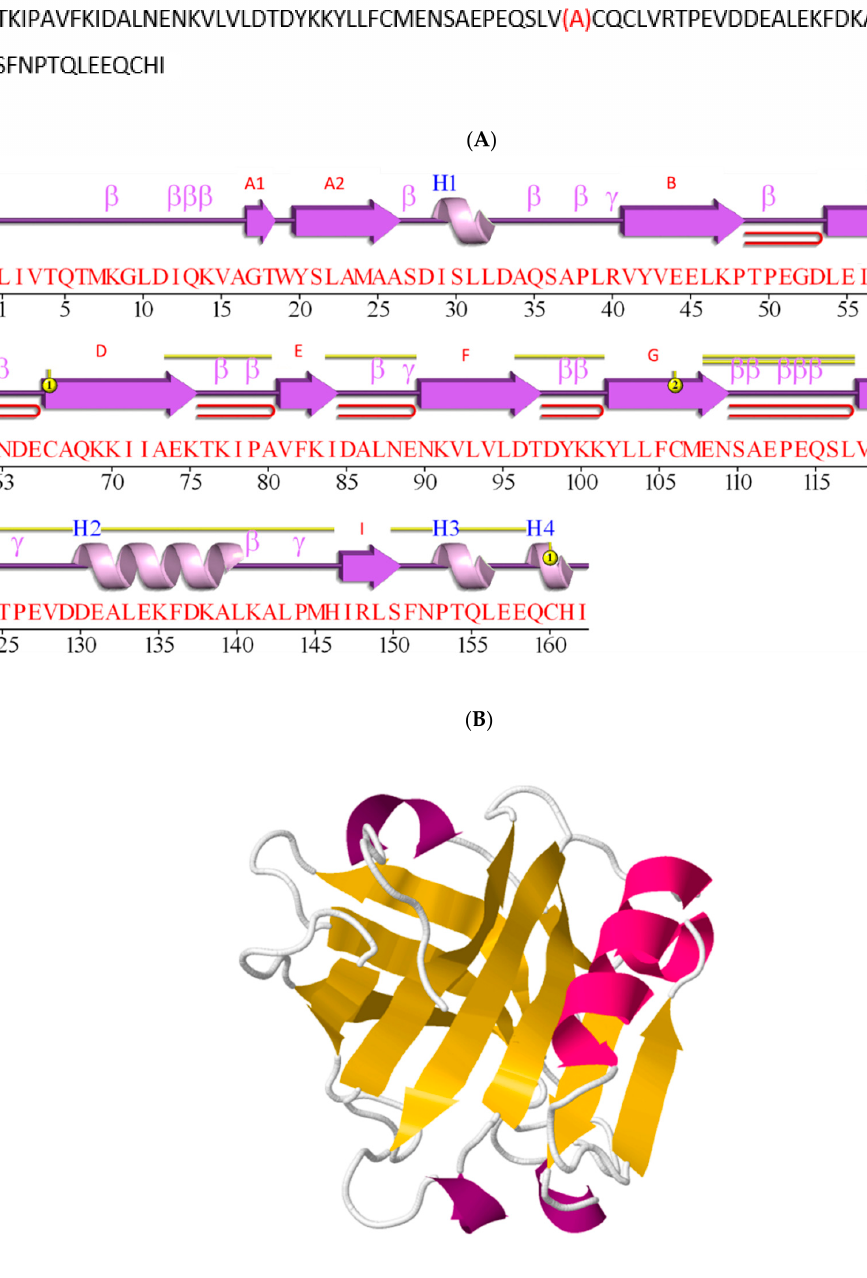
Figure 1. Structural features of bovine β -lactoglobulin. ( A ). Primary sequence of β -lactoglobulin variant A (B). ( B ). Diagram of secondary structural features of β -lactoglobulin. H1–H4, helical segments; A1–I, beta sheets; β , beta turn; γ , gamma turn; 1 (cid:79) = 2 (cid:79) ; disulphide bonds. Figure generated using PDBsum, PDB ID 1BSO [30], ( C ). Crystal structure of monomer of bovine β -lactoglobulin monomer, PDB ID: 1BEB [28]. Image generated using RCSB PDB